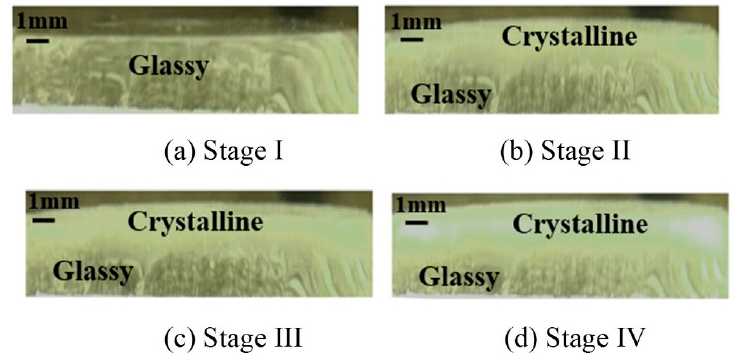
Figure 8. The heat flux time span of Sample R0.8A7 during the heat transfer test.